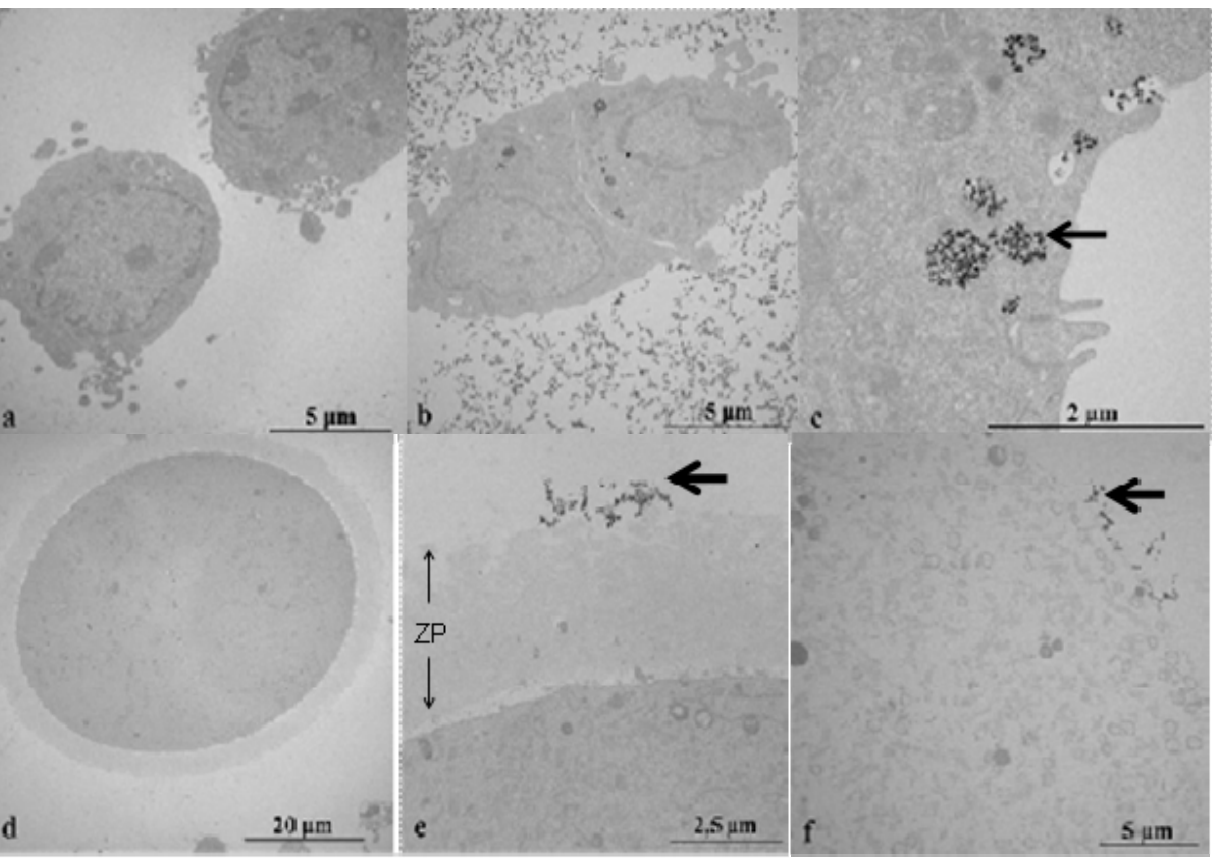
Figure 2. Transmission electron microscopy image of follicular cells and oocytes exposed to C O ENPs. ( a ) Unexposed follicular cells; ( b ) Follicular cells exposed to C e 2 (wide shot); ( c ) Follicular cells exposed to C surrounded by zona pellucida; ( e ) Oocyte surrounded by zona pellucida (ZP+) exposed to C O ENPs; ( f ) Oocyte not surrounded by zona pellucida (ZP − ) exposed to C e 2